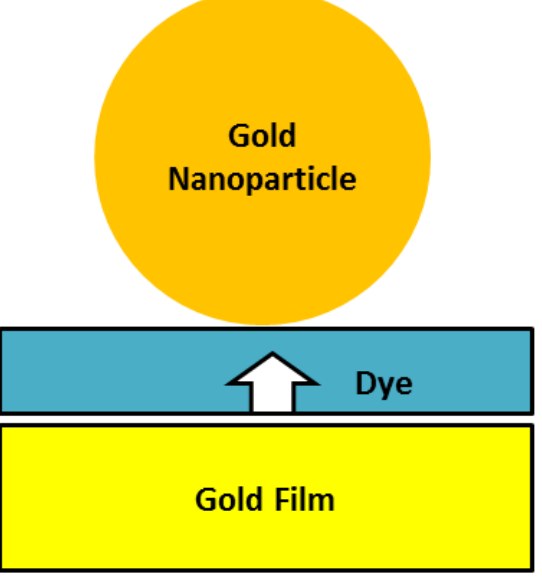
Figure 13. Diagram of NPoM structure. Adapted from Ref. [86].